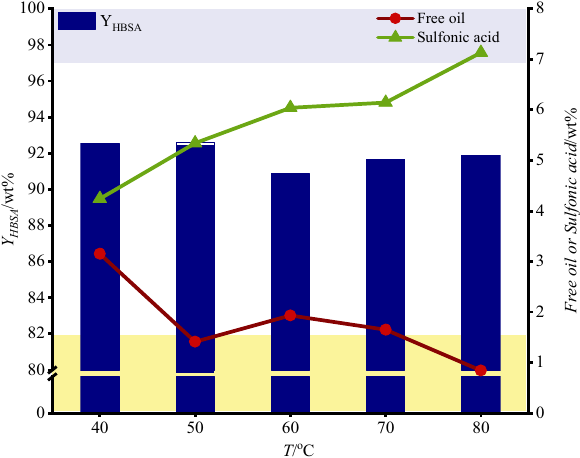
Figure 4: E ff ect of reaction temperature on the yield of HBSA, free oil and free sulfonic acid, featuring an SO 3 :HDB molar ratio of 1.20:1, SO 3 mass fraction of 10 wt% and residence time of 10.18 s. The pale navy blue parts indicate the range of HBSA content in the superior products, and the pale yellow parts indicate the range of free oil and sulfonic acid content of the superior products.